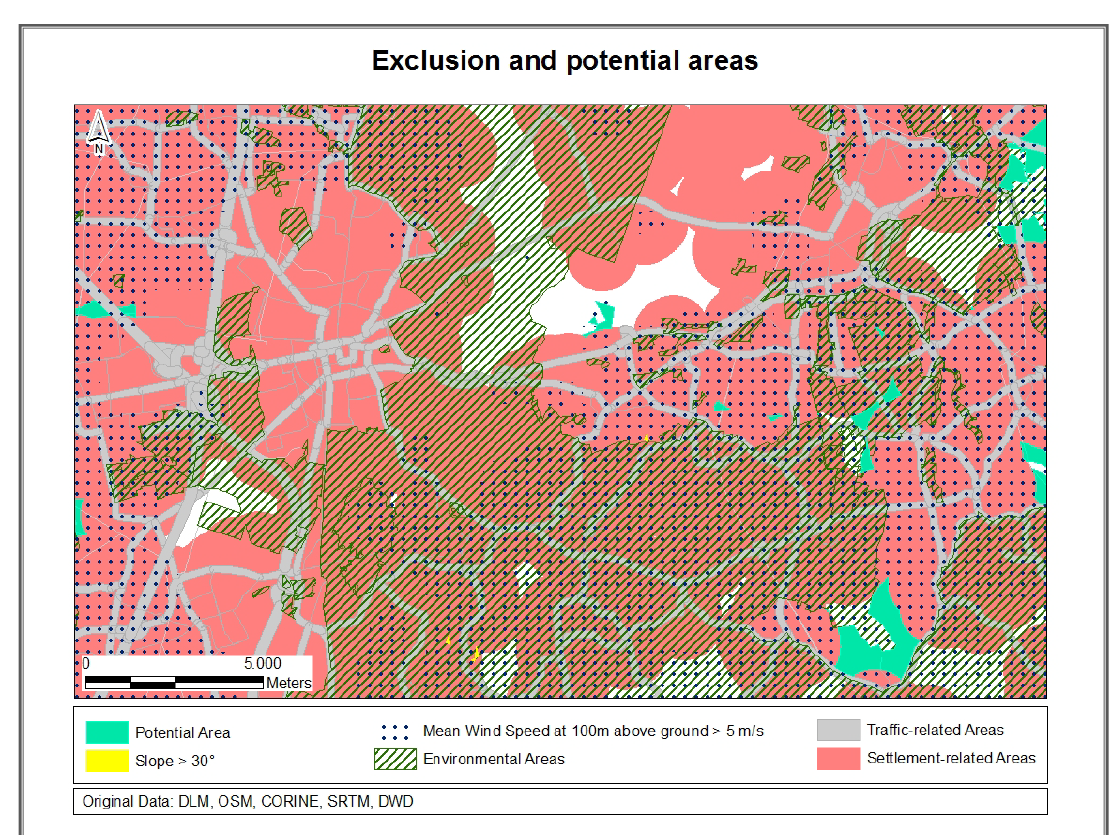
Figure 1. Exclusion areas and resulting potential